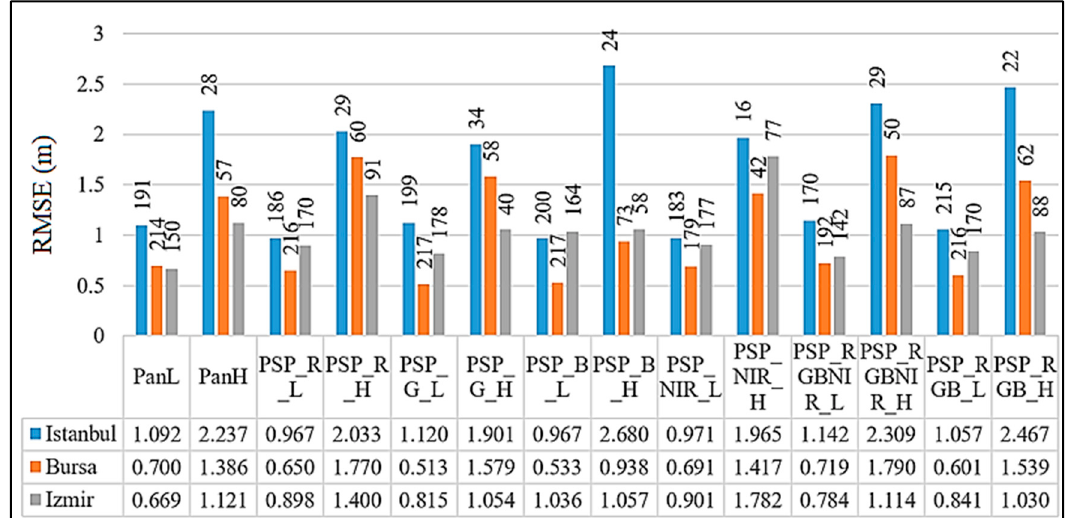
Figure 6. Comparison of the results of the orthorectification process for different study areas based on the RMSE (number of the validated Ground Control Points (GCPs) given over each bar).